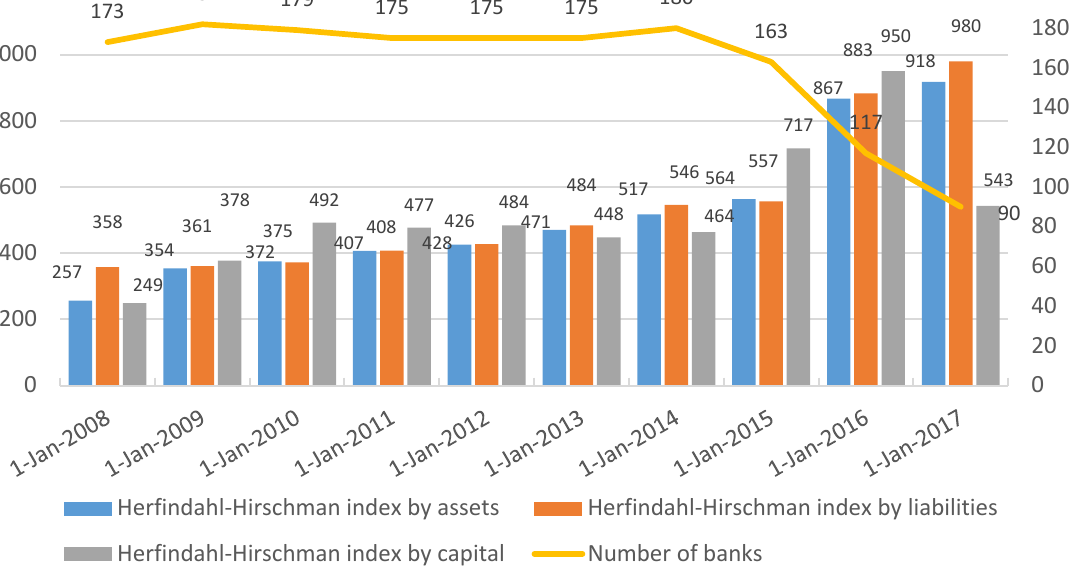
Figure 2. Dynamics of Herfindahl-Hirschman index in the banking system of Ukraine in 2007 –